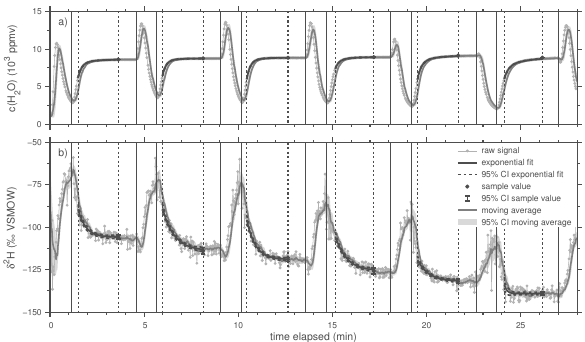
Figure 3. Exemplary time series signal representing the acquisition of a pore water stable isotope profile using the in situ sampling sys- tem with permanently installed ADS probes and a dilution sequence of 60s flushing and 210s sampling. Solid vertical lines enclose peri- ods of sample arrival. Exponential fits use data from the asymptotic period up to 150s after start of sample arrival, as enclosed by the dashed vertical lines. A moving average (15s backward) is provided for illustrative